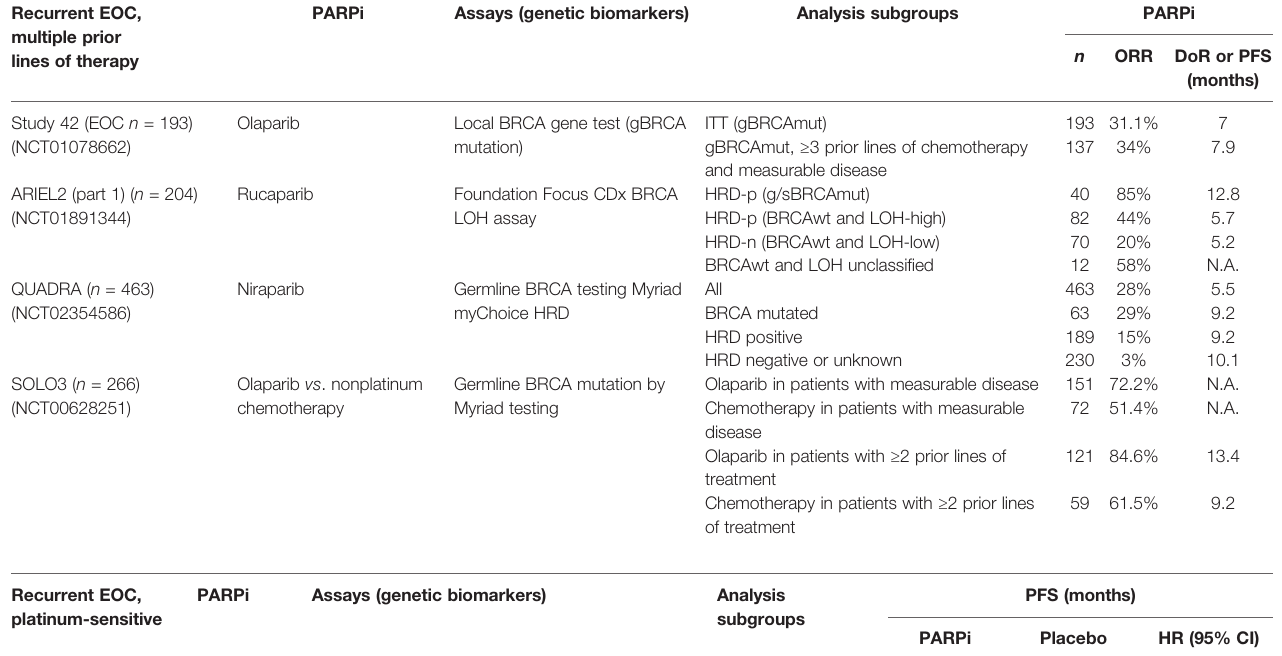
TABLE 2 | Clinical trials of PARPi in recurrent or newly diagnosed epithelial ovarian cancer (EOC). Recurrent EOC, multiple prior